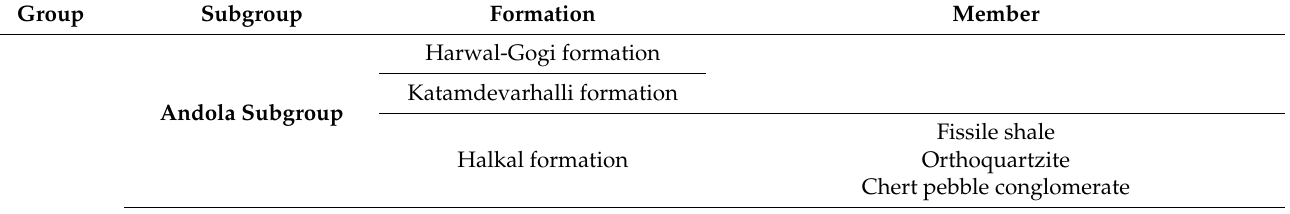
Table 1. Lithostratigraphic sequence of the Bhima basin (after